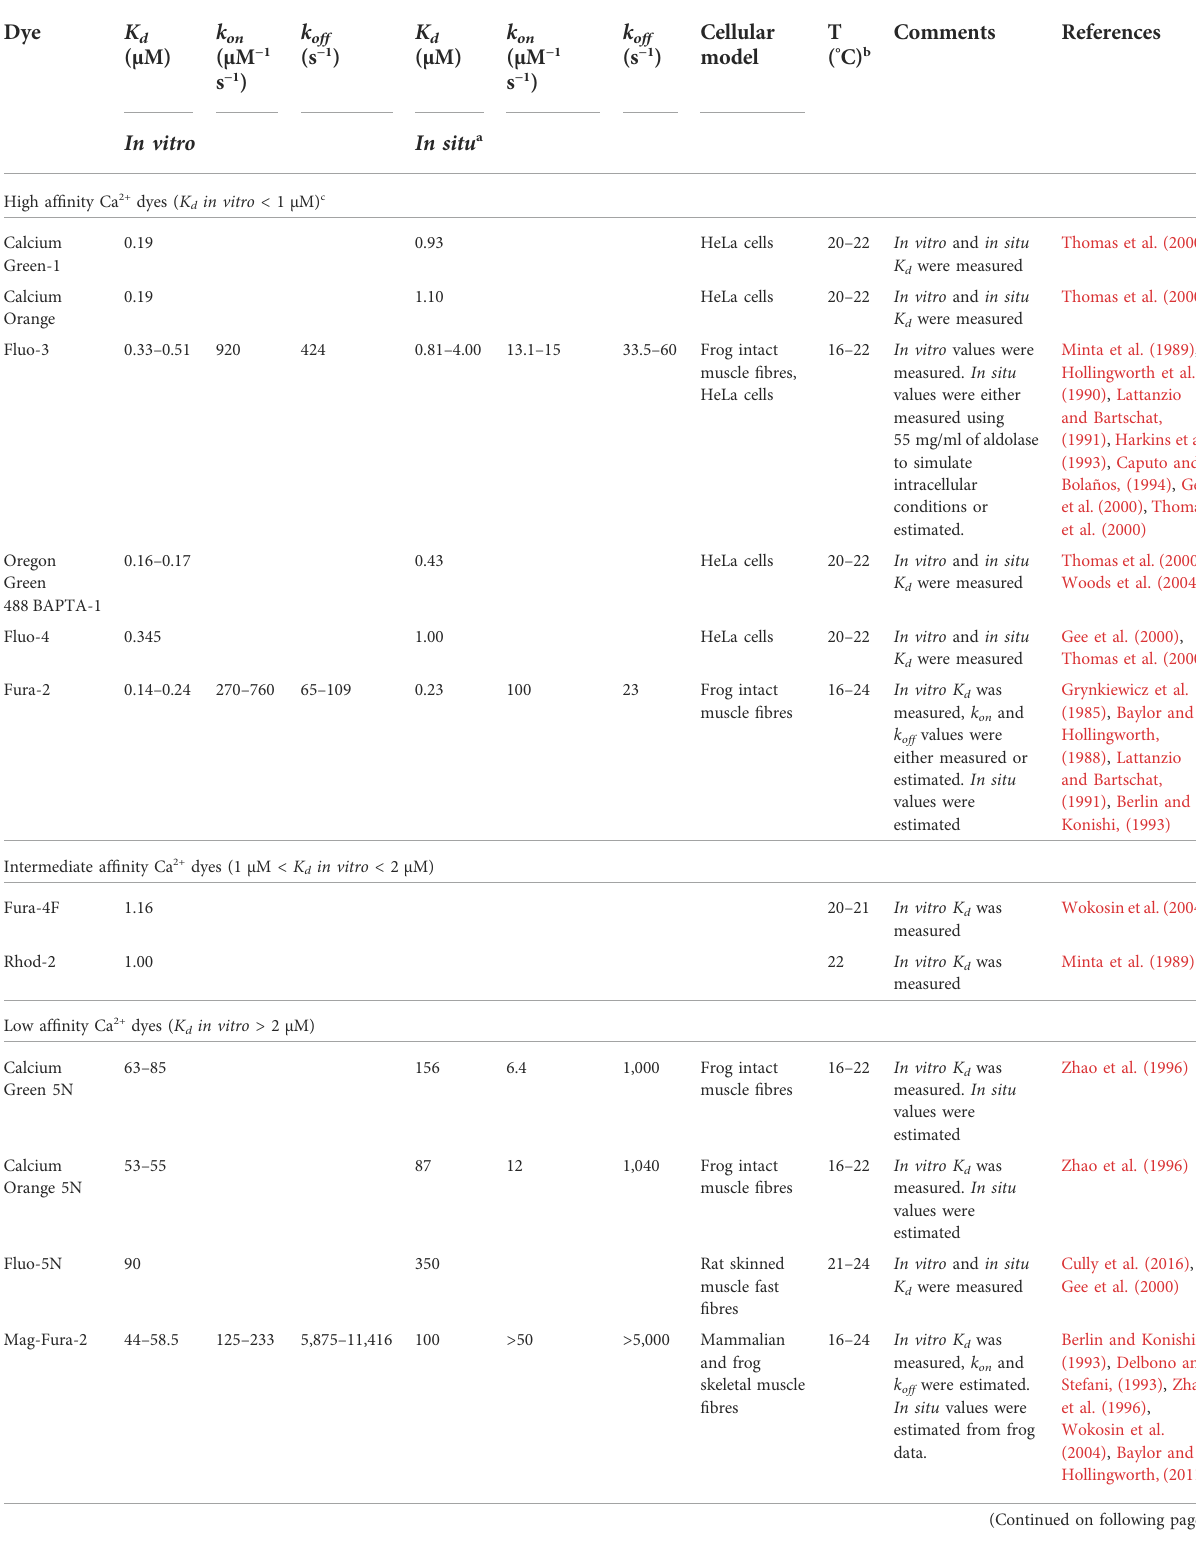
TABLE 1 Best Ca 2+ dyes to study ECC in skeletal muscle, with their af fi nity and rate constants relevant for calibration of their fl uorescence